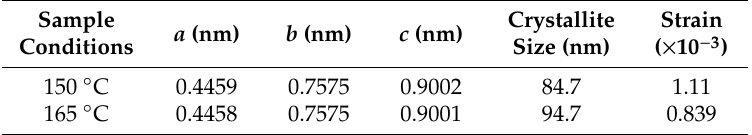
Table 2. Summary of XRD data including lattice parameters ( a , b , and c ), crystallite sizes, and strain of the two orthorhombic PbCl 2 thin films deposited at different substrate temperatures.